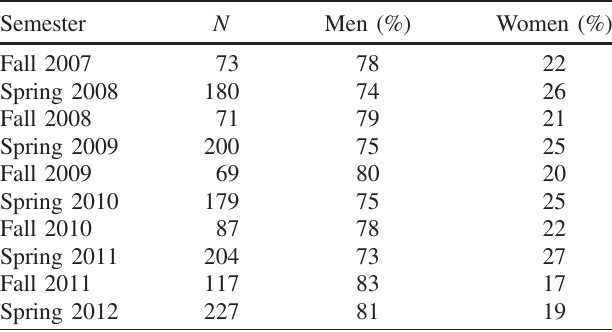
TABLE I. Class size and gender composition by